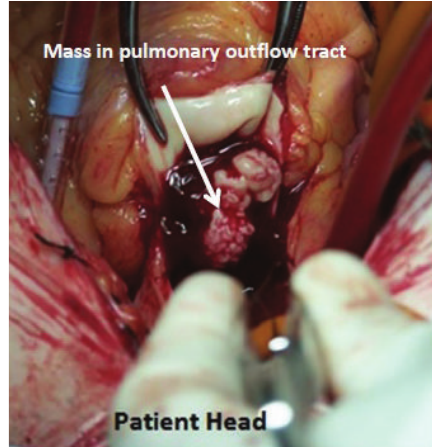
Figure 2: View from median sternotomy showing large bilobed mass in right ventricular outflow tract (divided open) with destruc- tion of pulmonary valve before excision and